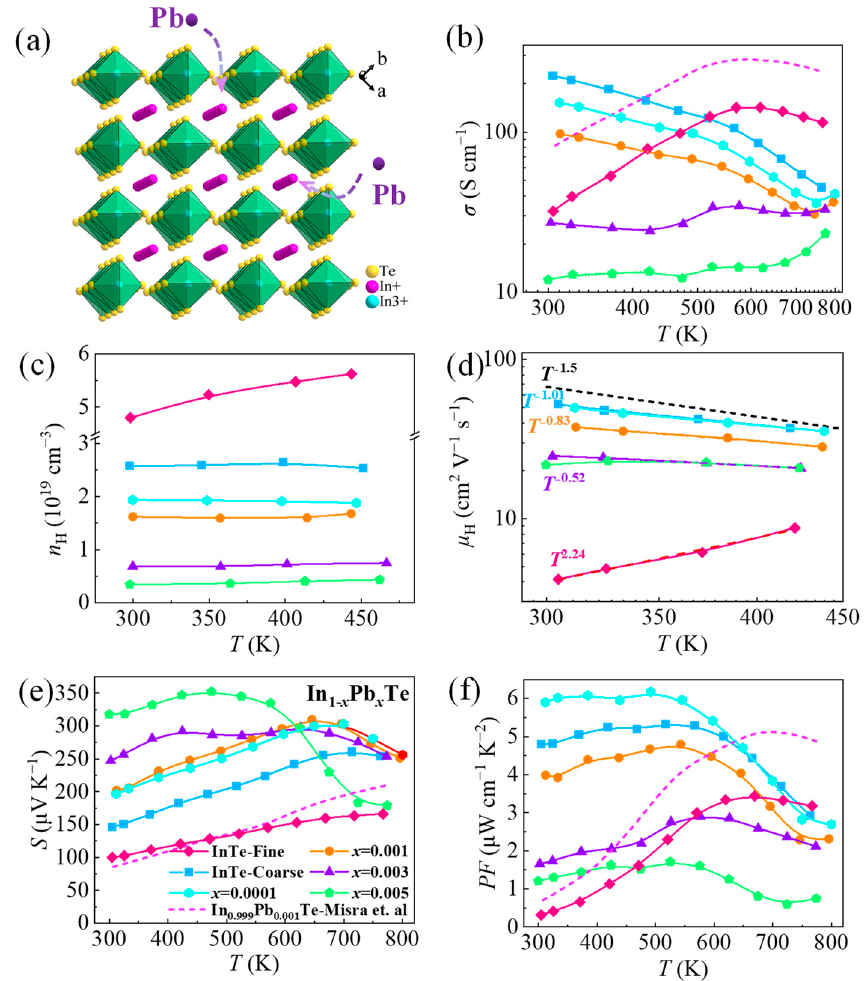
Figure 3. ( a ) Diagram of the Pb doping at In + site in InTe with the covalent chained crystal structure. Temperature dependence of the electrical properties of the sieved fine InTe and coarse In 1- x Pb x Te ( x = 0, 0.0001, 0.001, 0.003, 0.005). ( b ) Electrical conductivity, ( c ) Hall carrier concentration, ( d ) Hall carrier mobility, ( e ) Seebeck coefficient, and ( f ) power factor [21].